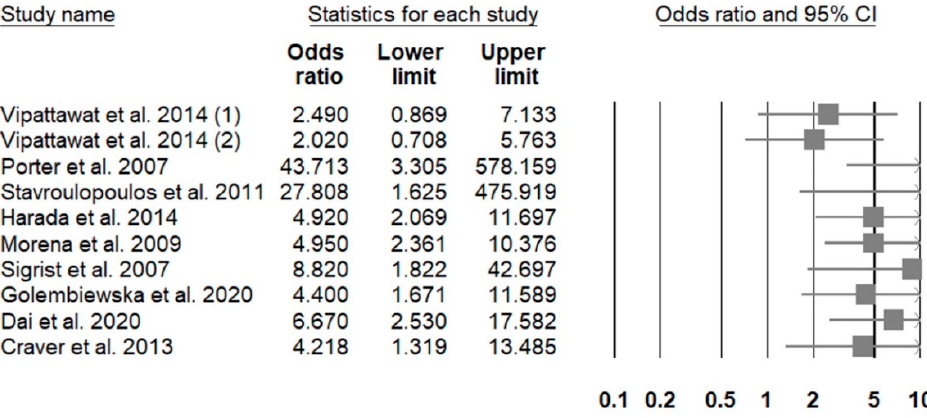
Figure 2. A forest plot showing the male to female risk among patients with non-dialysis chronic kidney disease.